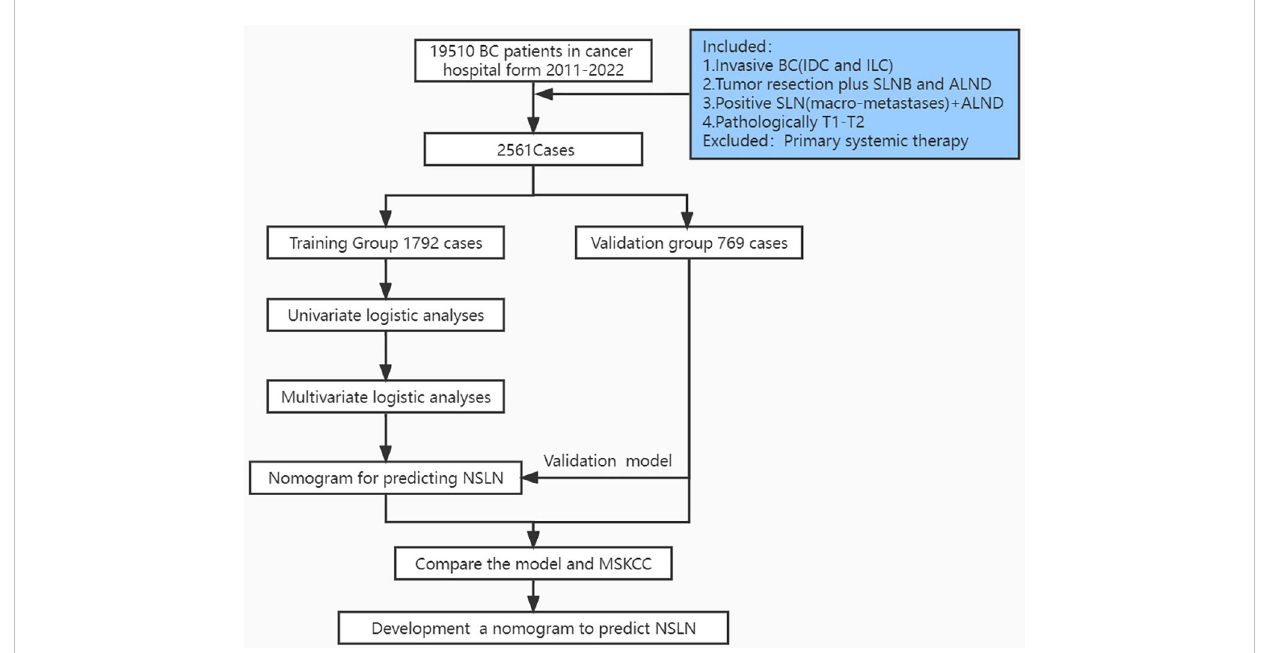
FIGURE 1 Flowchart illustrating the establishment and validation of nomograms for predicting non-SLN metastases in patients with SLN